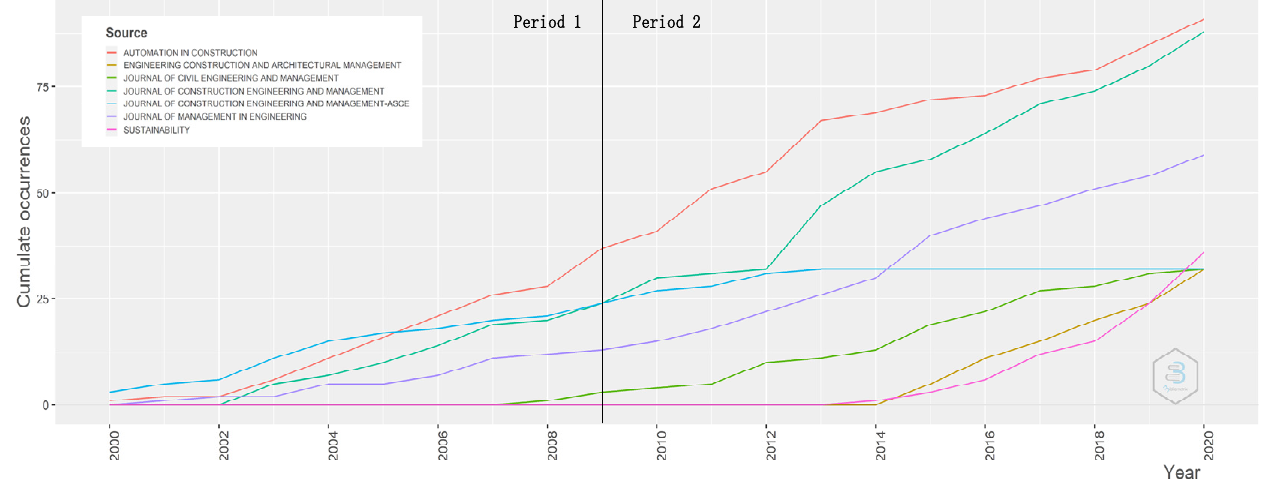
Figure 4. Source growth map of the two periods ( generated by Biobliometrix R ).